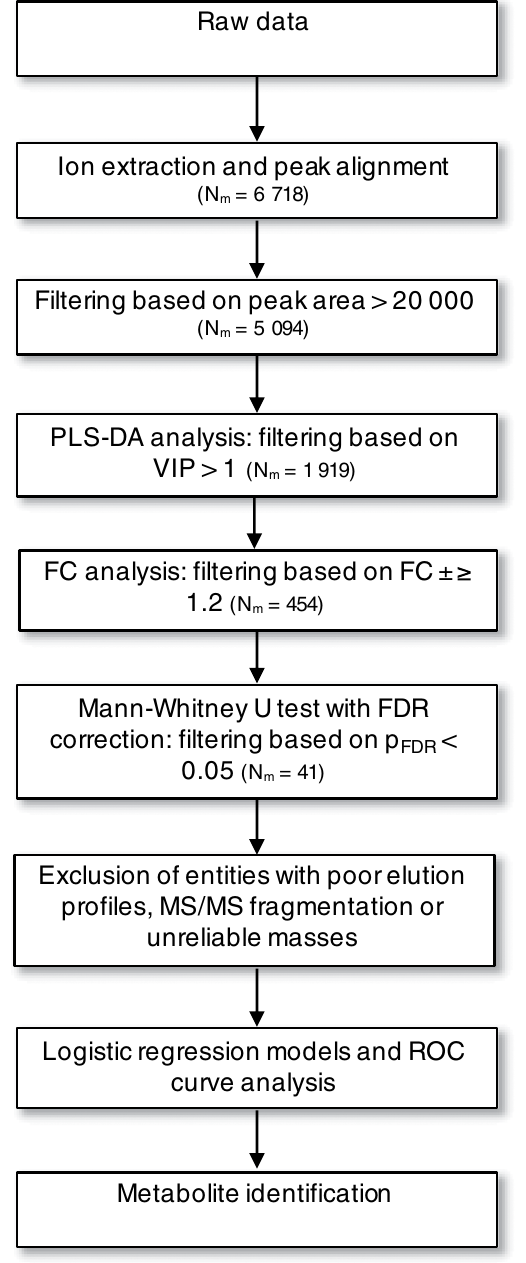
Figure 1. Summary of data processing and statistical analysis steps prior to metabolite identification. N m , number of metabolites; PLS-DA, partial least-squares discriminant analysis; VIP, variable importance on projection; FC, fold